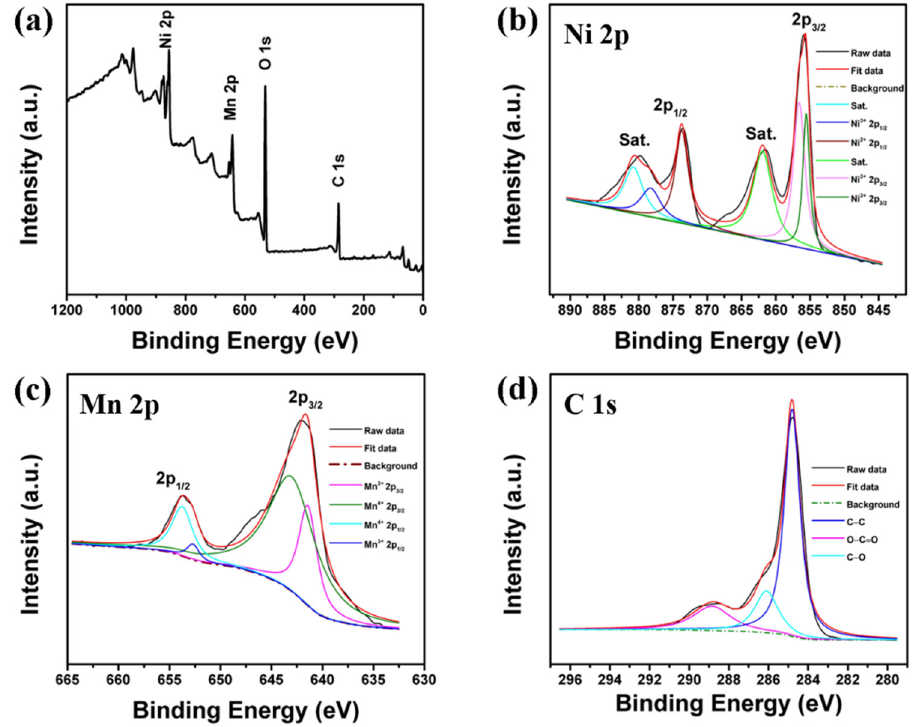
Figure 3. XPS spectra of the rGO-NiMnO 3 ( a ) survey spectrum, ( b ) Ni 2p, ( c ) Mn 2p, and ( d ) C 1s.